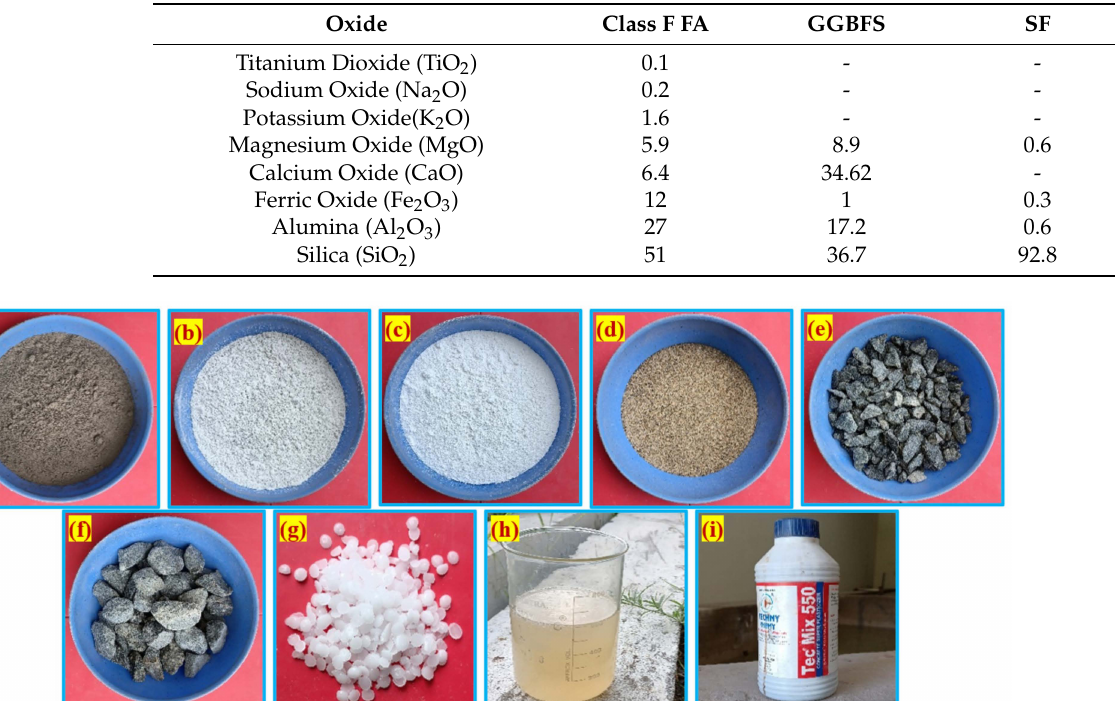
Figure 4. Raw materials used in this research: ( a ) fly ash, ( b ) GGBFS, ( c ) silica fume, ( d ) fine aggregate, ( e ) coarse aggregate 12.5 mm, ( f ) coarse aggregate 20 mm, ( g ) sodium hydroxide flakes, ( h ) sodium silicate solution, ( i )